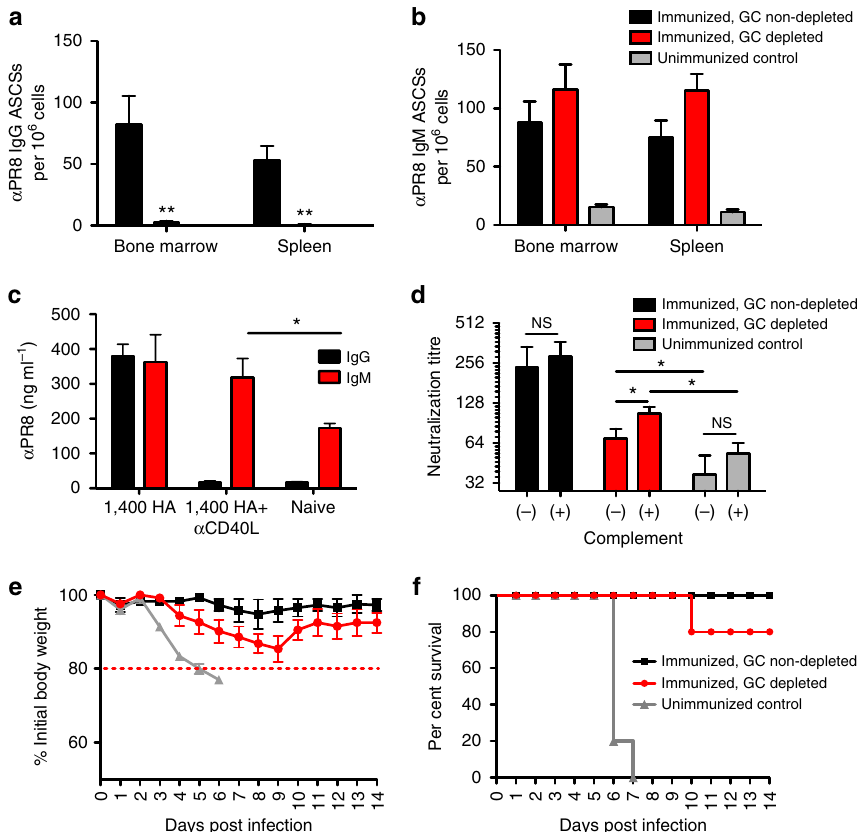
Figure 6 | GC independent IgM LLPCs are capable of neutralizing influenza virus in vitro and protecting the animal against infection in vivo. ( a , b ) PR8-specific IgG (filled black square) and IgM (filled red square) ASCs, respectively, as measured by ELISPOT from cohorts 2 months post immunization with 1,400 HA PR8 ( n ¼ 5)—treated with control Ig or a CD40L at days 6, 8 and 10 to inhibit GCs—or age-matched naive control mice (filled grey square open square n ¼ 3). ( c ) Antigen-specific IgG (filled black square) and IgM (filled red square) titres as measured by serum ELISA at 150 days post immunization, with or without a CD40L treatment. ( d ) Neutralization of PR8 virus by day 150 sera from PR8-immunized cohorts ( n ¼ 5), with (filled red square) or without (filled black square) a CD40L treatment, or age-matched naive controls (filled grey square open square n ¼ 3), with or without complement; Student’s t -test ** P o 0.005. ( e , f ) Mice immunized with A/PR/8/34 virus, with or without a CD40L treatment, were challenged with 10xLD 50 of virus 1 year post immunization, with morbidity (body weight loss) and survival rate measured, respectively. The mean ( ± s.e.m.) of five mice in each cohort is